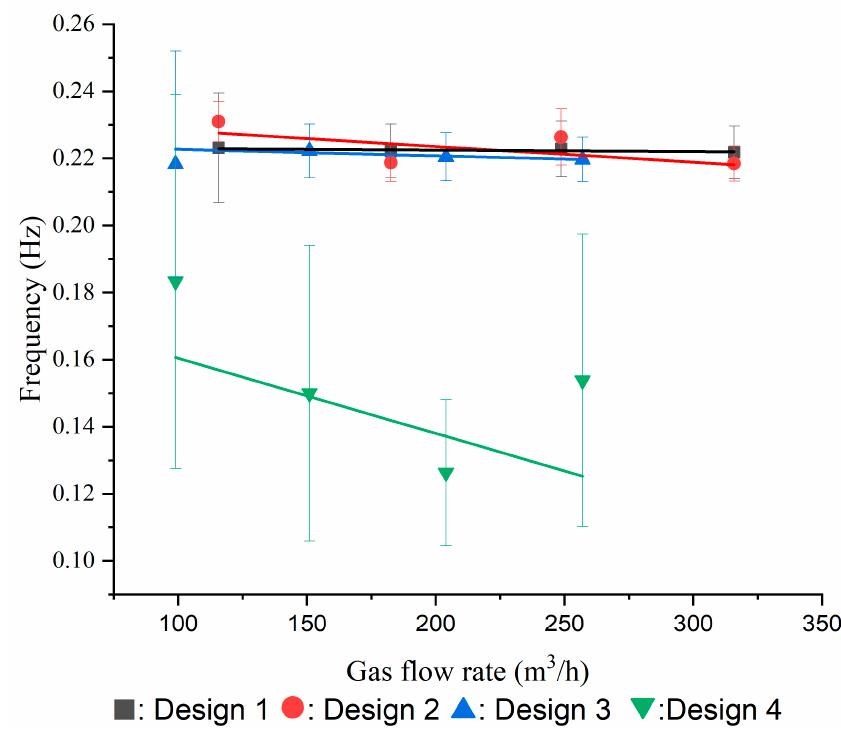
Figure 9. Dominant frequencies for different configurations and gas flow rates.